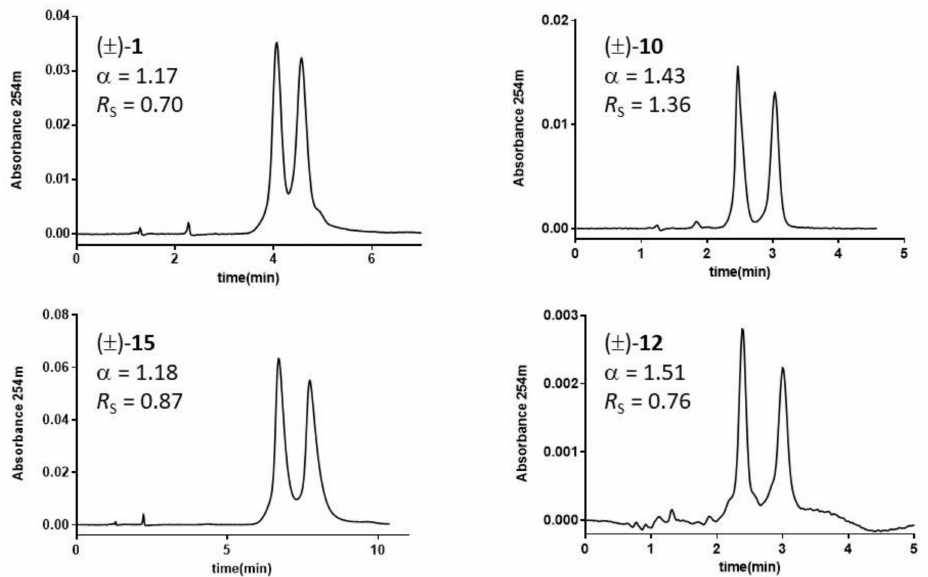
Figure 3. Chromatograms of DHP analytes 1 , 10 , 12 , and 15 on Pirkle-type 3020-( S )- tert -leucine and ( R )-1-( α -naphthyl)ethylamine ( CSP-3 ) columns. Mobile phase: Hex-EtOH (95:5, v / v ); flow rate: 0.7 mL/min; room temperature; UV detection: 254